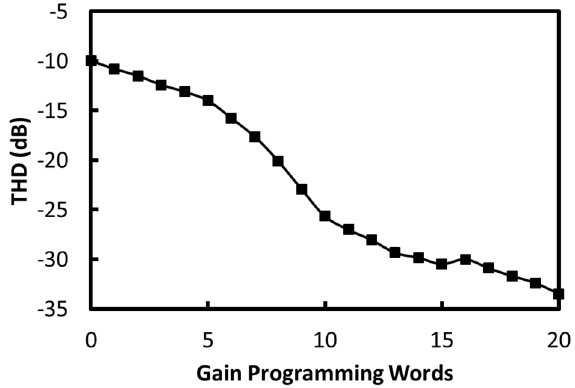
Figure 17. ( a ) Measured gain and gain step error of the TX analog baseband. ( b ) Measured gain and gain error deviation of the TX analog baseband.